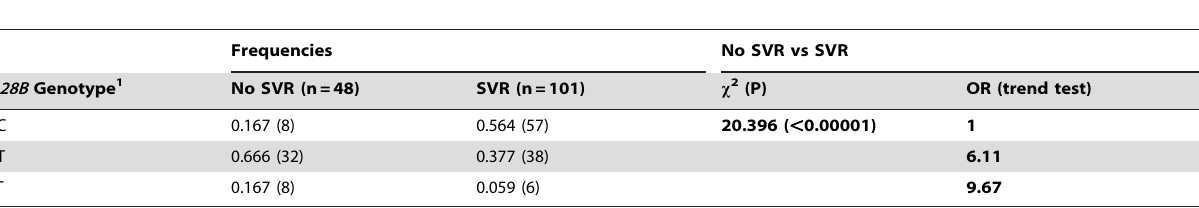
Table 2. The IL28B SNP, rs12979860, is associated with HCV treatment response in a cohort of HCV/HIV-1 co-infected patients.